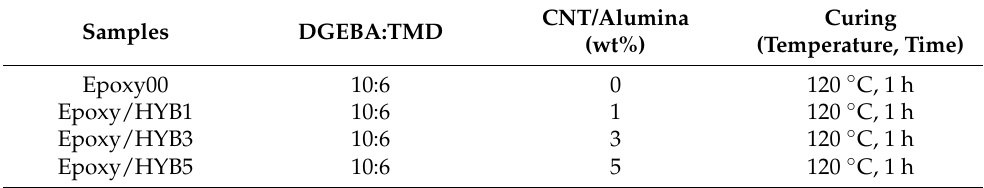
Table 1. Summary of preparation of epoxy nanocomposite